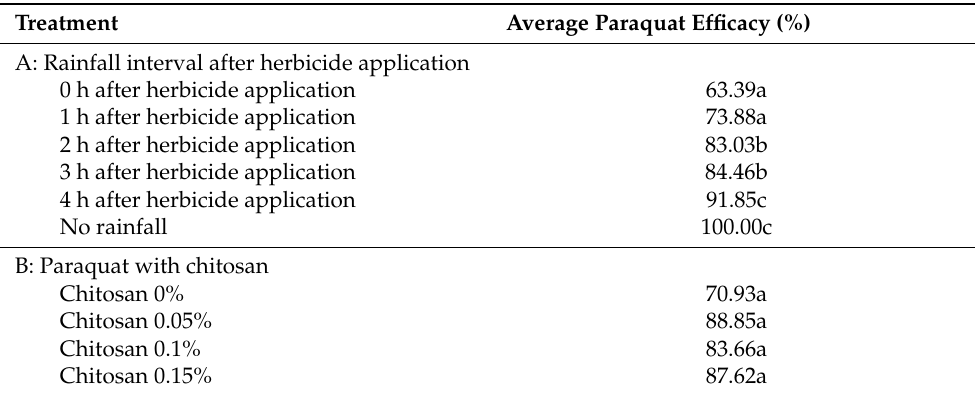
Table 4. Effect of simulated rainfall on herbicidal efficacy of a mixture of paraquat and chitosan against Imperata cylindrica at different time intervals after mixture